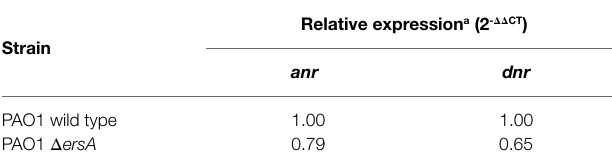
TABLE 2 | Relative expression of anr and dnr in wild-type vs. Δ ersA PAO1 strains determined by